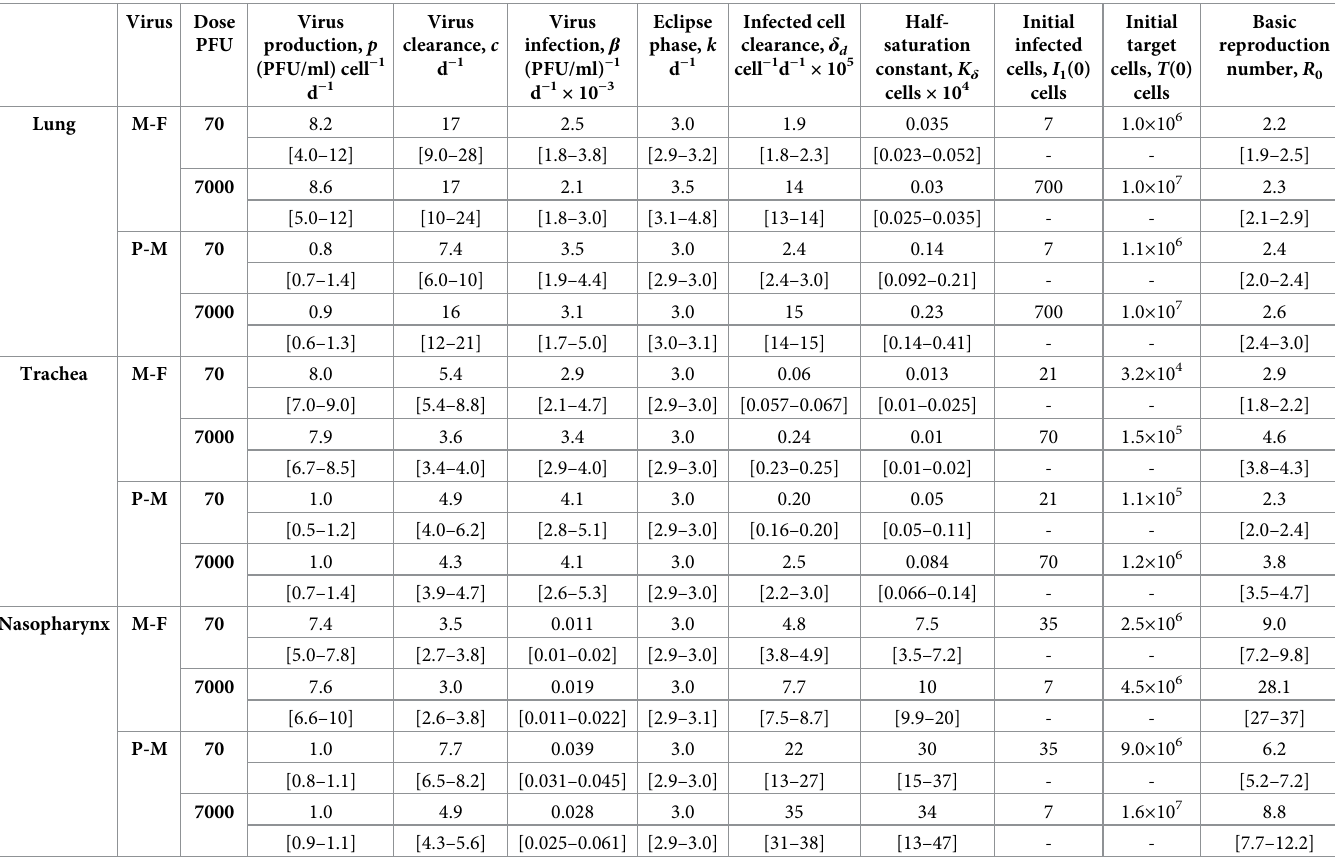
Table 2. Maximum likelihood estimates of population parameters. Population parameters (median values) and 95% confidence intervals obtained from fitting the model (Eqs (3)–(6)) to estimated viral loads from the lung, trachea, or nasopharynx of mice infected with either the rSeV-luc(M-F � ) virus (“M-F”) or the rSeV-luc(P-M) virus (“P-M”) at a high d/v or low d/v. The initial numbers of target cells ( T (0)) and infected cells ( I 1 (0)) were fixed to the indicated value, and the initial number of produc- tively infected cells ( I 2 (0)) and the initial virus ( V (0)) were set to